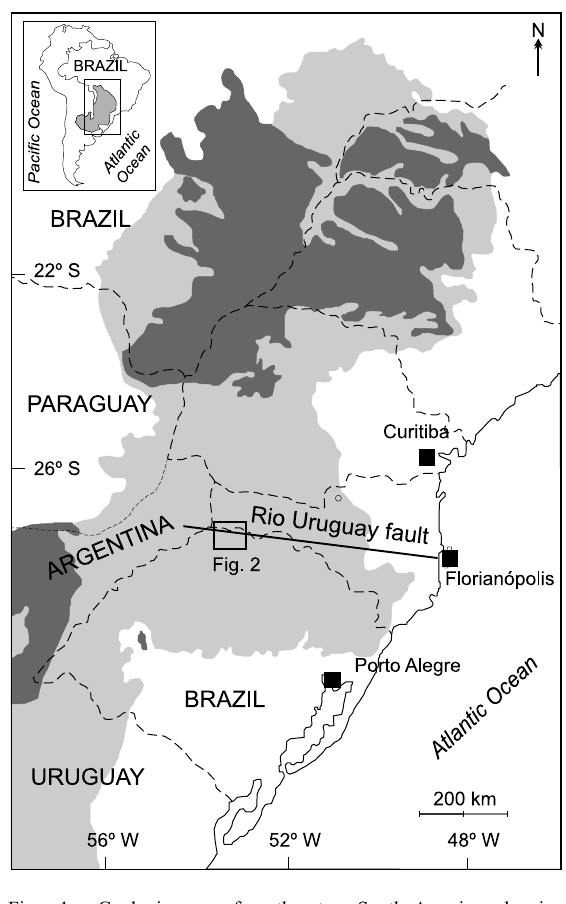
Fig. 1 – Geologic map of southeastern South America, showing the Serra Geral Group basalts and rhyodacites (light gray) in the Paraná basin, the underlying sedimentary rocks, Precambrian base- ment (white), sedimentary cover rocks (dark gray), modified from Peate et al. (1992). Studied Vista Alegre region